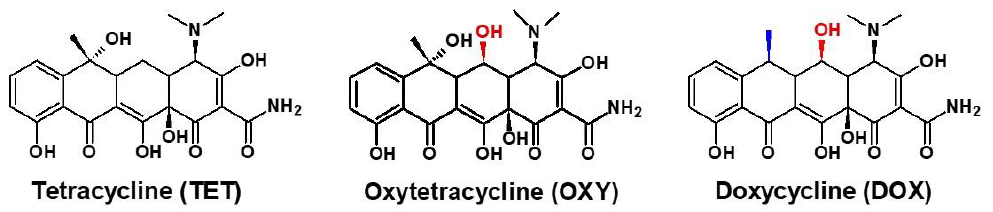
Figure 1. Chemical structures of tetracyclines.